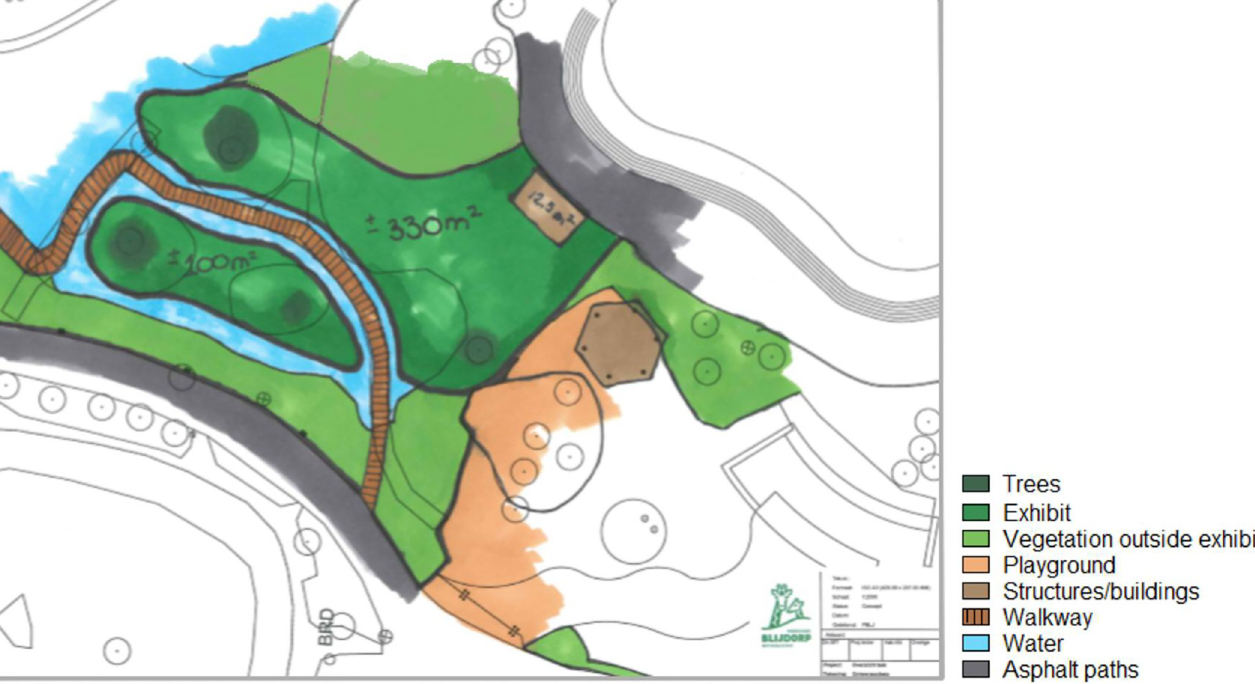
PLOS ONE | https://doi.org/10.1371/journal.pone.0252456 June 4,